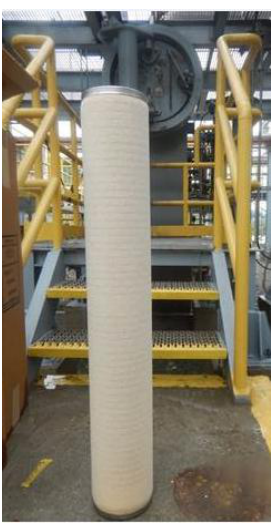
Figure 4—Filter